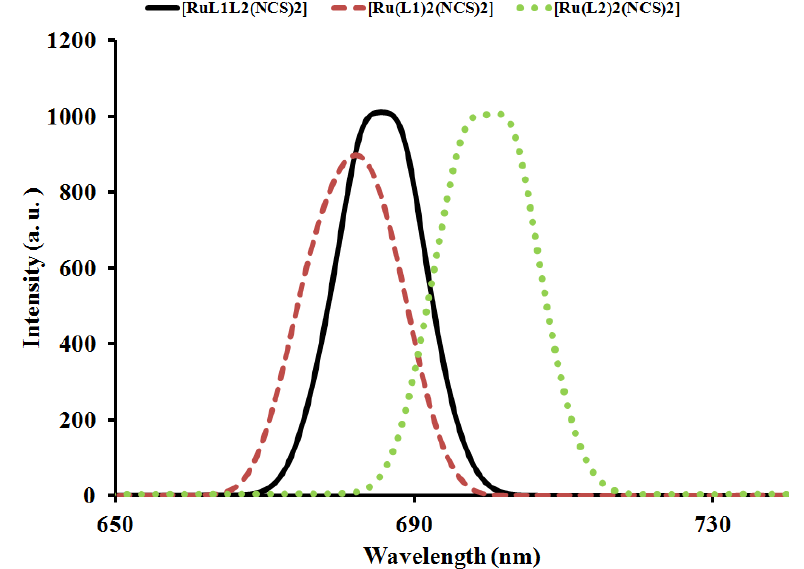
Figure 4. Comparison of emission spectral of [RuL [Ru(L ) (NCS) 2 2